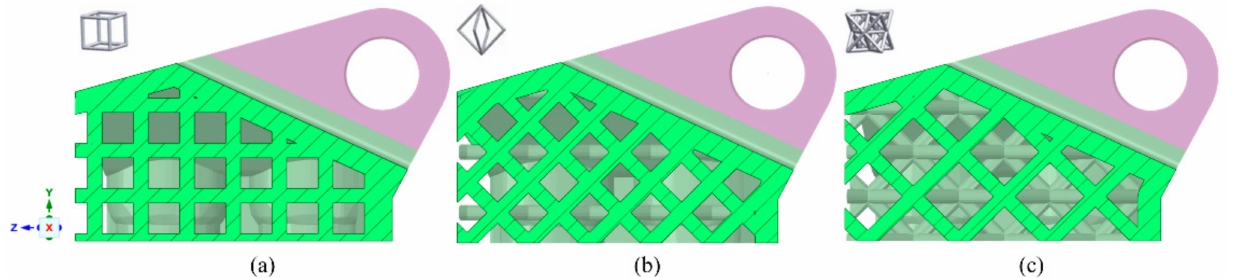
Figure 9. Three different cells in the z orientation: ( a ) cubic, ( b ) octahedral, and ( c )